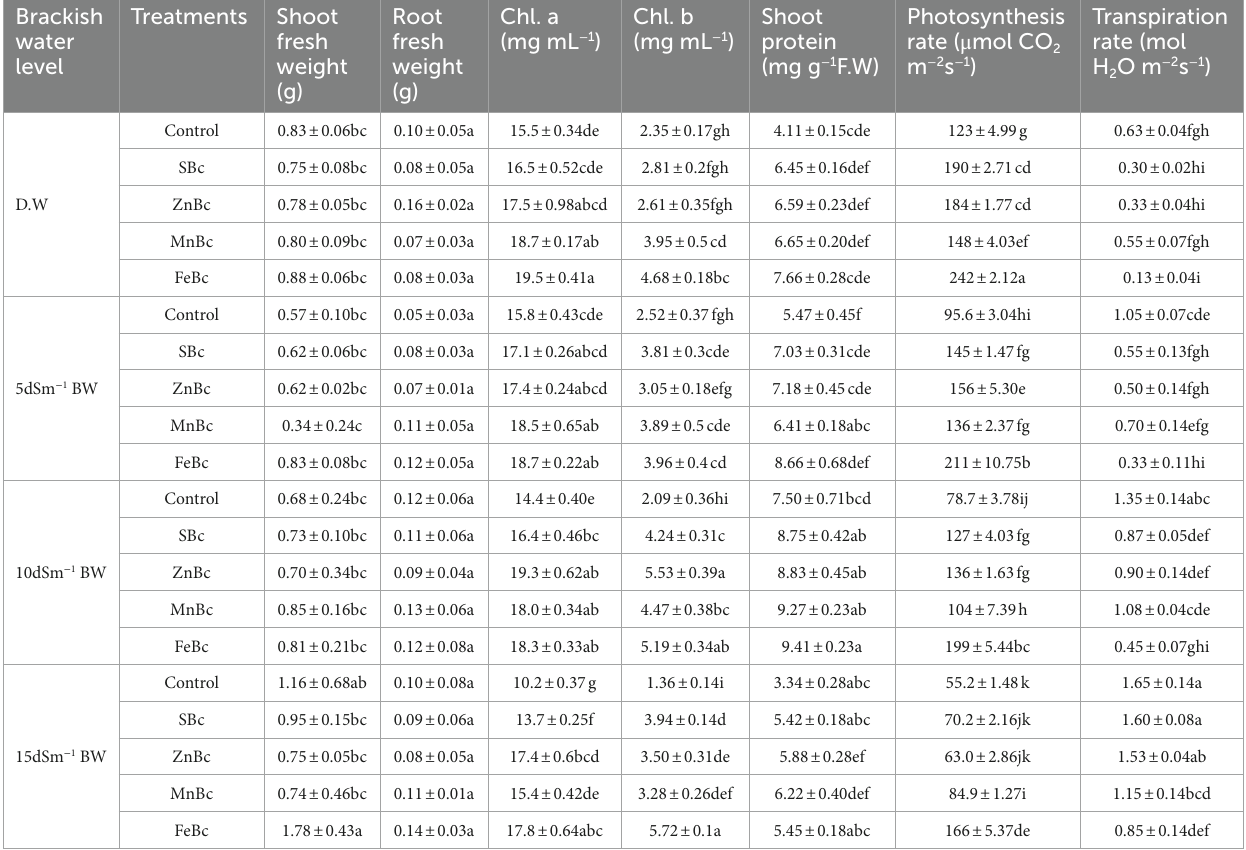
The given data represented the mean values of four replicates ( n = 4) ± standard error and different letters represented the significant difference declared by LSD test at p ≤